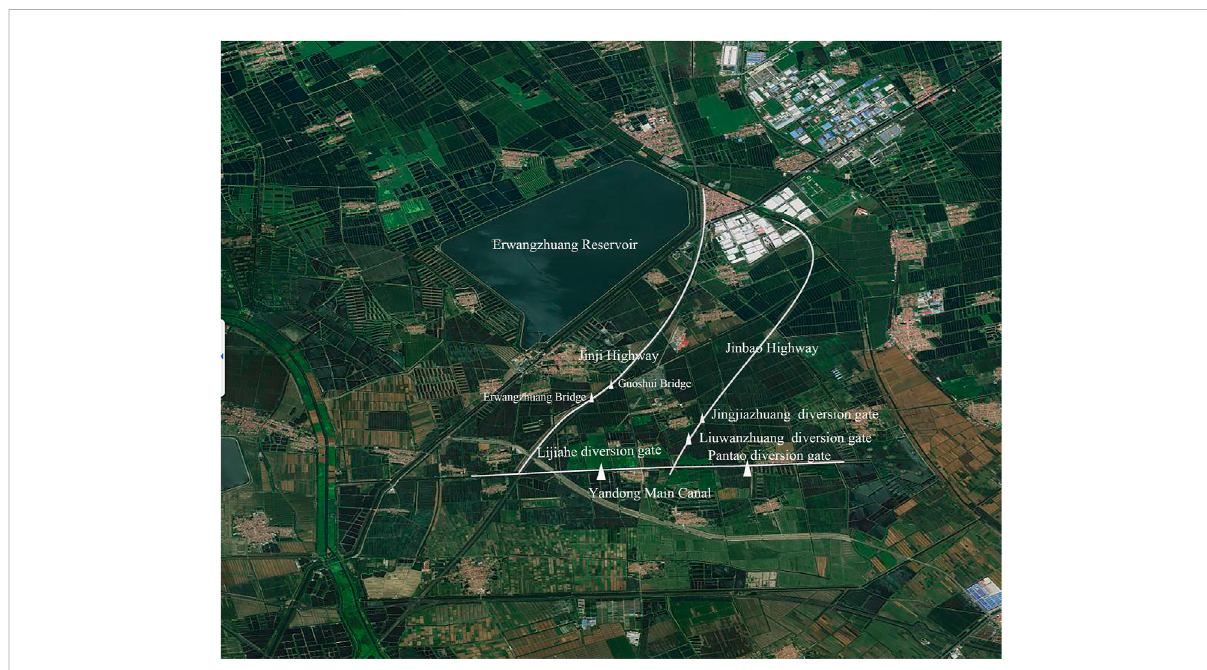
FIGURE 4 Location scheme of fl ood diversion of the Jinbao Highway. To illustrate the locations of some gates, we use Photoshop for image processing. Scheme 2 is to choose the entrance gate at the Jingjiazhuang fl ood diversion gate approximately 1 km north of the Liuwanzhuang fl ood diversion gate, which has theadvantage of relatively low terrainand no obstructionafter fl ood diversion. However, it is far from the Erwangzhuang Bridge, the fl oodway of the Jinji Highway, and is located at the backwater of Fengjiazhuang and Jingjiazhuang. Hence, the fl ow conditions of fl ood diversion are relatively